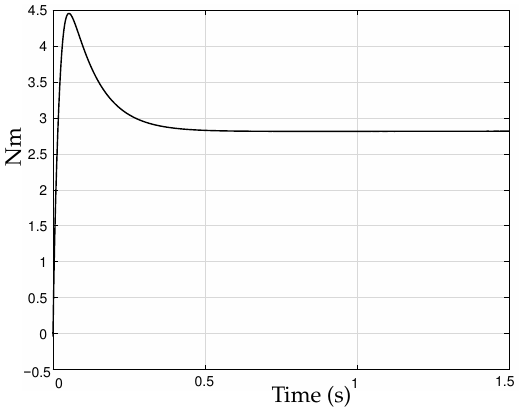
Figure 2. Braking torque T b .